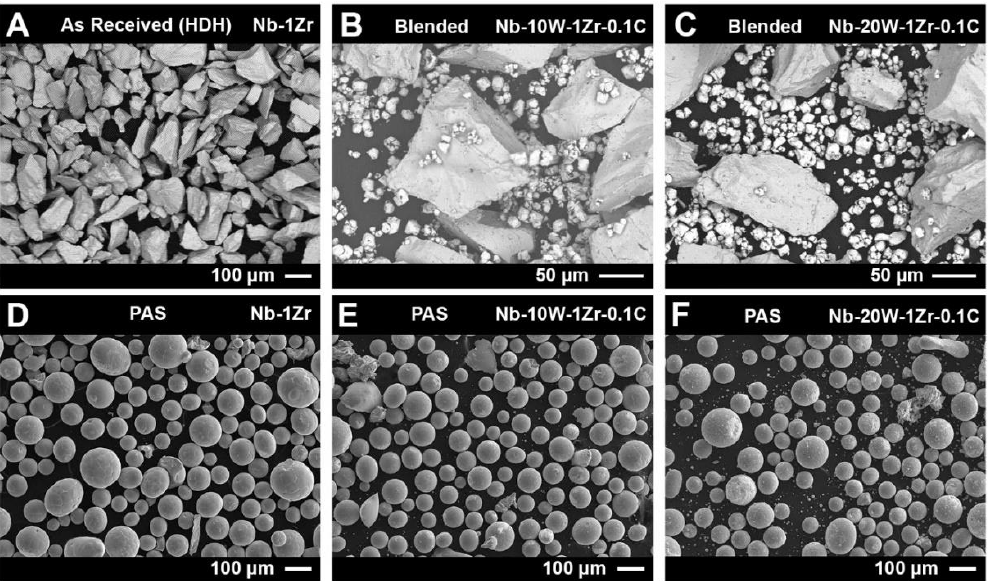
Figure 3. SEM images of as received ( A ) hydride-dehydride Nb-1Zr, ( B ) blended Nb-10W-1Zr-0.1C, ( C ) blended Nb-20W- 1Zr-0.1C, and plasma alloy spheroidized ( D ) Nb-1Zr, ( E ) Nb-10W-1Zr-0.1C, and ( F ) Nb-20W-1Zr-0.1C. Table 2. Chemistry as measured by ICP-OES and LECO for Nb-1Zr as received powder, and for all 3 alloy powders after PAS and Nb-W-Zr-C powders.